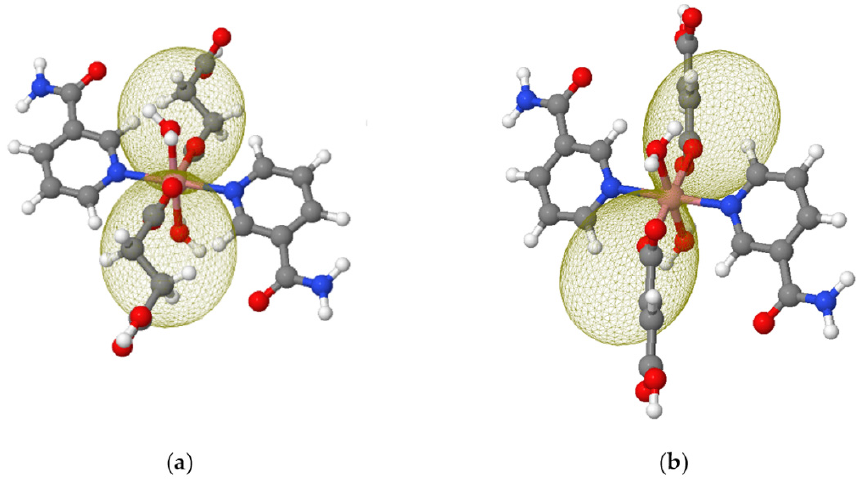
Figure 3. A cut-off from respective polymeric systems I and II forming a neutral mononuclear model molecule: ( a ) 1 ; ( b ) 2 (right). The yellow transparent surface shows calculated directional dependence of molecular